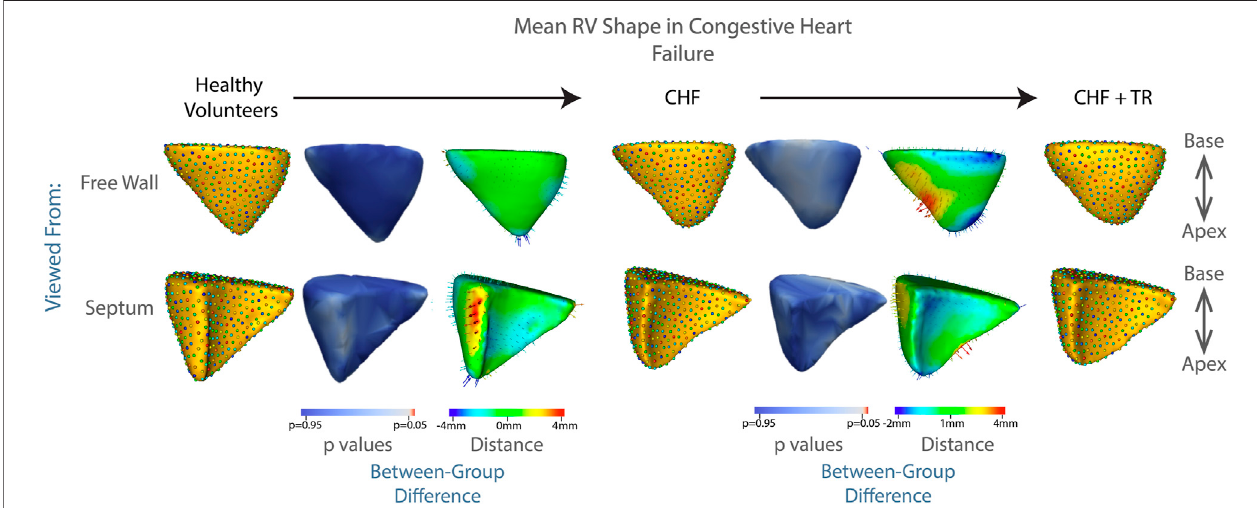
FIGURE7| ProgressionofRVshapechangeincongestiveheartfailure(CHF).Themeanshapeoftherightventricleinhealthyvolunteers,patientswithCHFwithout TR, and patients with CHF and TR are shown in columns 1, 4, 7. Columns 3 and 6 show the difference between the group mean shapes. The arrows indicate the directionofgroupdifferences,and thecolorrepresentsthemagnitudeofthegroupdifference. Columns 2and 5showthe p -valuesofthegroupdifferences.Theregions with red color showcase statistically signi fi cant group differences.